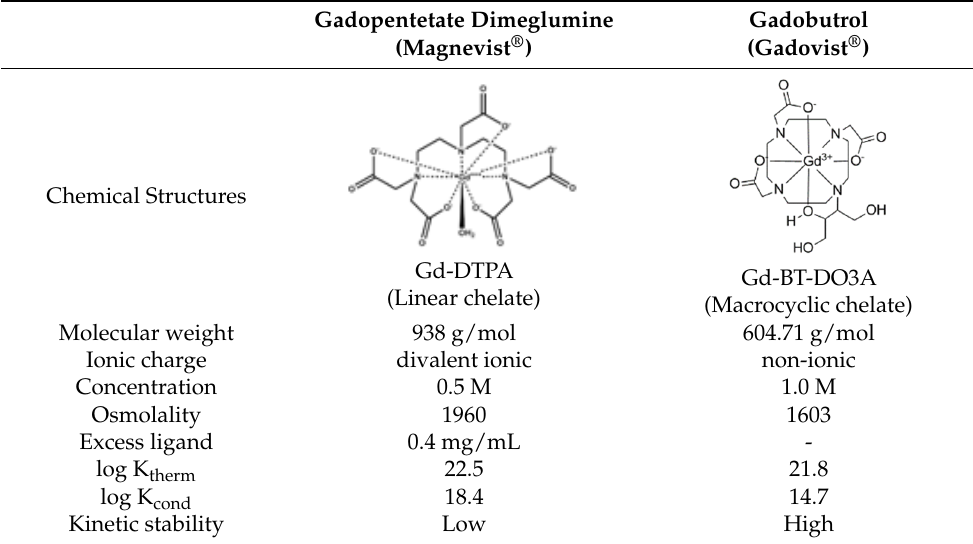
Table 1. Characteristics of Magnevist ® and Gadovist ® [2,32,33]. Gadopentetate Dimeglumine